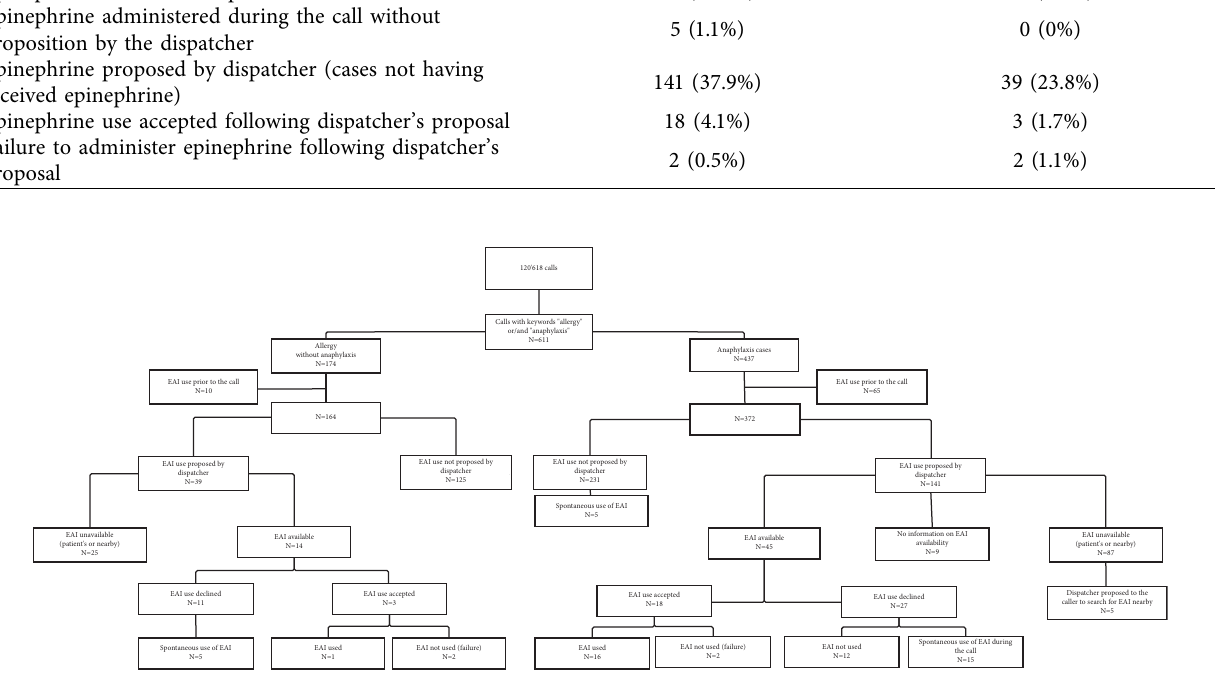
Figure 1: Flowchart.